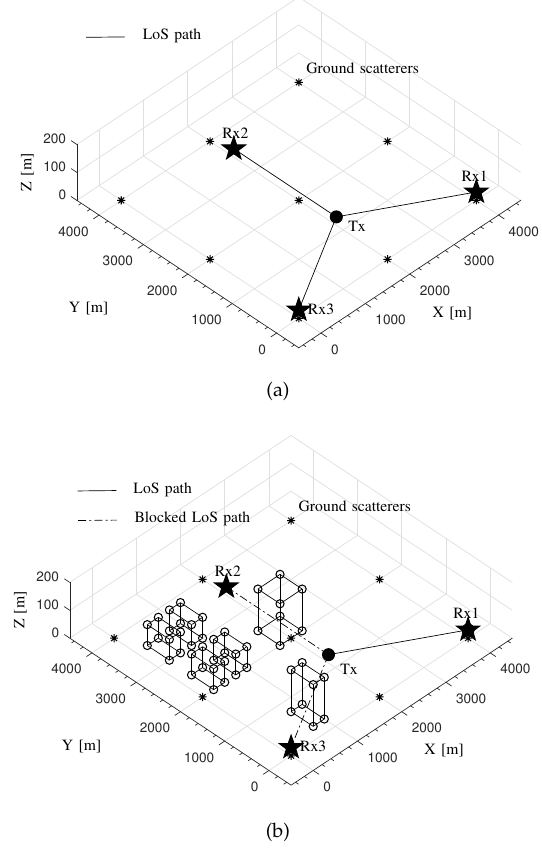
Figure 8. The digital maps for the Line-of-Sight (LoS) and the Non Line-of-Sight (NLoS) scenarios for the verification of the proposed performance-evaluation approach using a commercial TDoA localization system. ( a ) The LoS scenario; ( b ) The NLoS